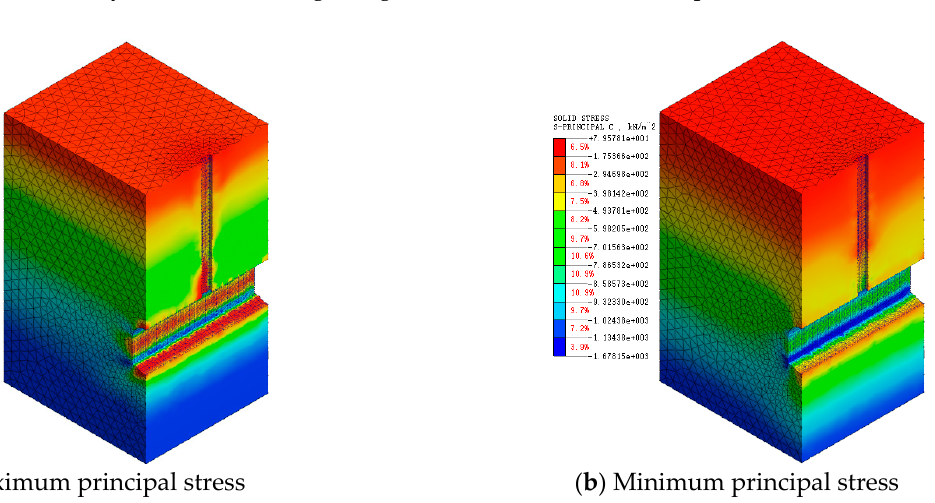
Figure 15. Principal stress of surrounding